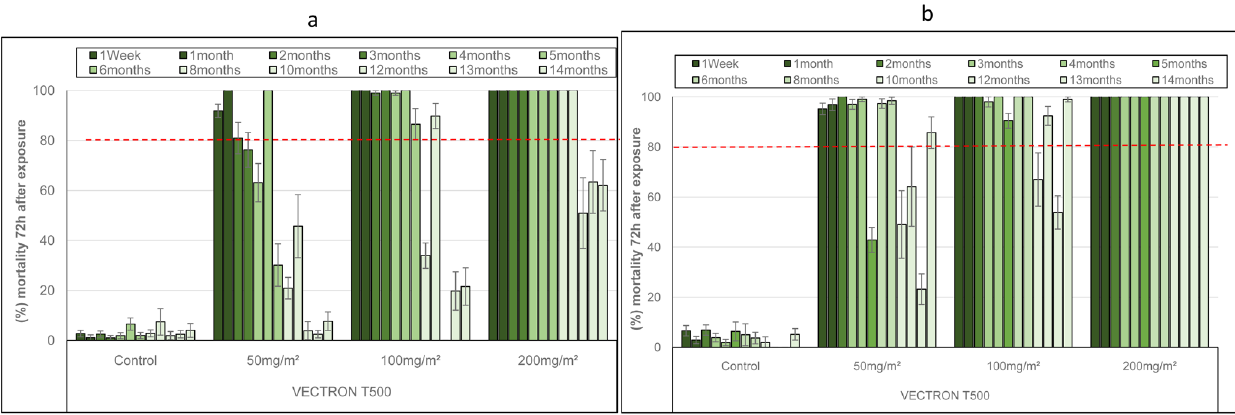
Figure 2. Monthly mortality of Anopheles coluzzii pyrethroids resistant strain exposed on treated concrete ( a ) and mud ( b ) blocks substrates in World Health Organization (WHO) cones bioassays. Approximately 100 mosquitoes 2-5 days old were exposed for 30min to each treatment and mortality recorded 72 hours after exposure. Overall, 10 cones per dose and 10 mosquitoes per cone were used at of tested mosquitoes at each time point. Each histogram represents the mean mortality rate and error bars represent ± 95% confidence interval (CI). The dotted line represents WHO